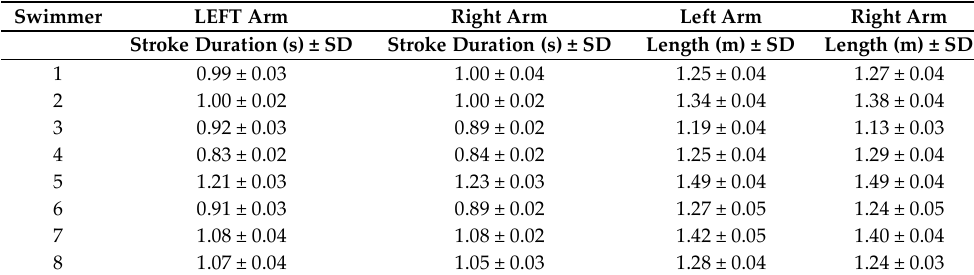
Table 2. Left and right arm mean stroke durations and stroke lengths including the standard deviation (SD) for each swimmer.